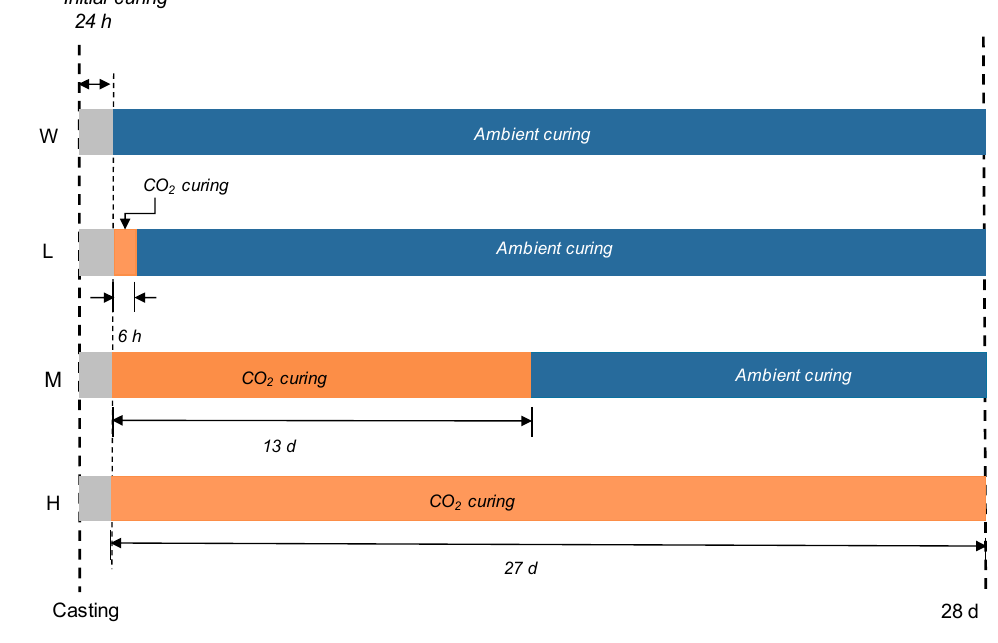
Figure 1. Curing regimes used in this study.